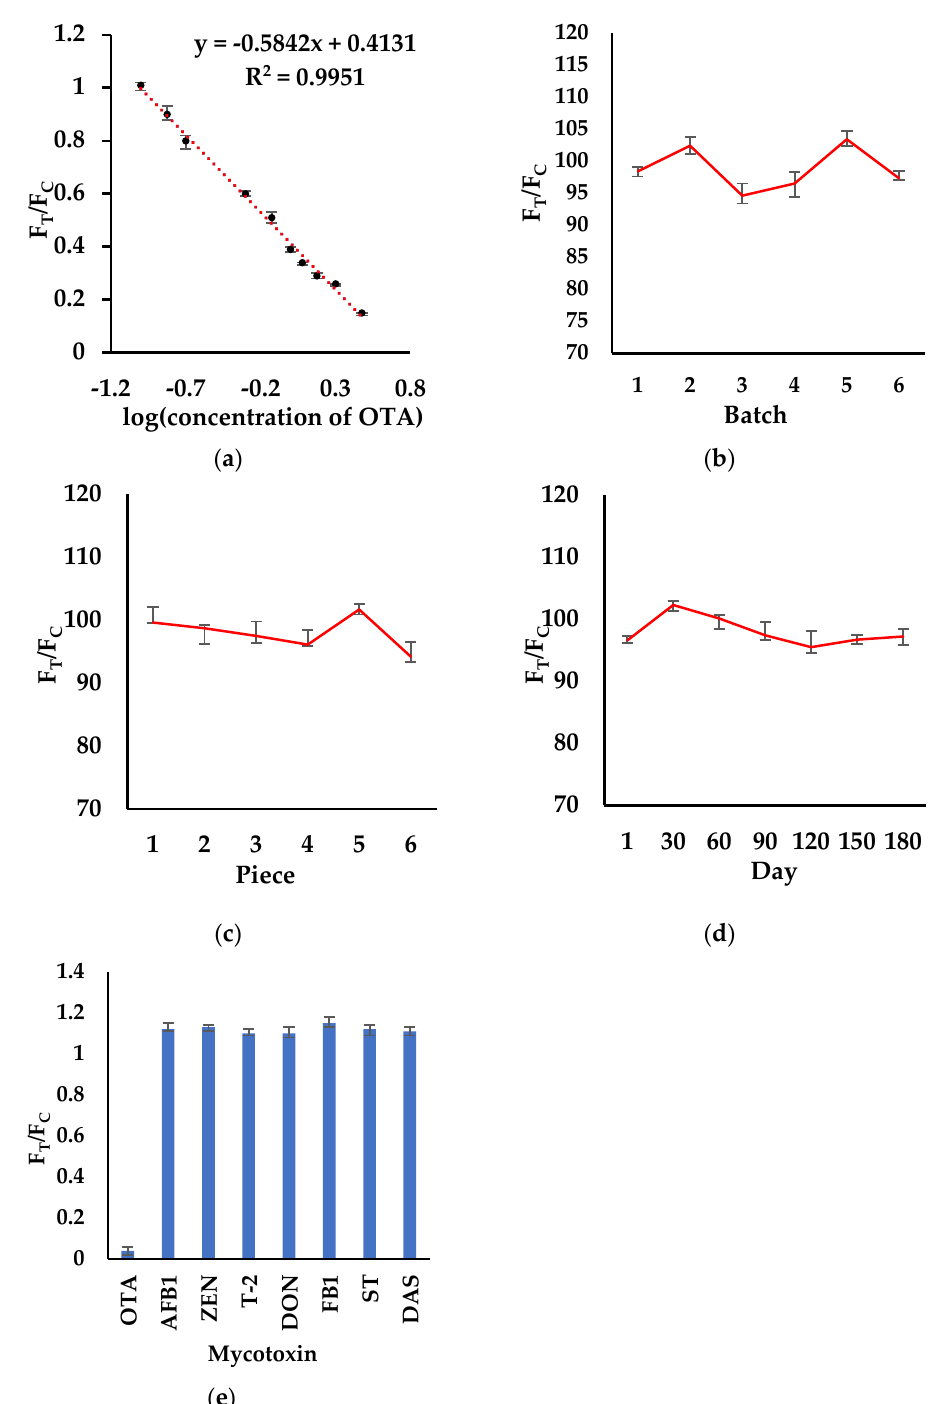
Figure 3. OTA calibration curves ( a ), interassay recovery batch reproducibility ( b ), intraassay recovery batch repeatability ( c ), 180-day stability ( d ), and specificity aflatoxin B1 (AFB1), zearalenone (ZEN), T-2 toxins, deoxynivalenol (DON), fumonisin B1 (FB1), sterigmatocystin (ST), and diacetoxyscirpenol (DAS) ( e ). Each data represented the average value from three measurements in wheat.